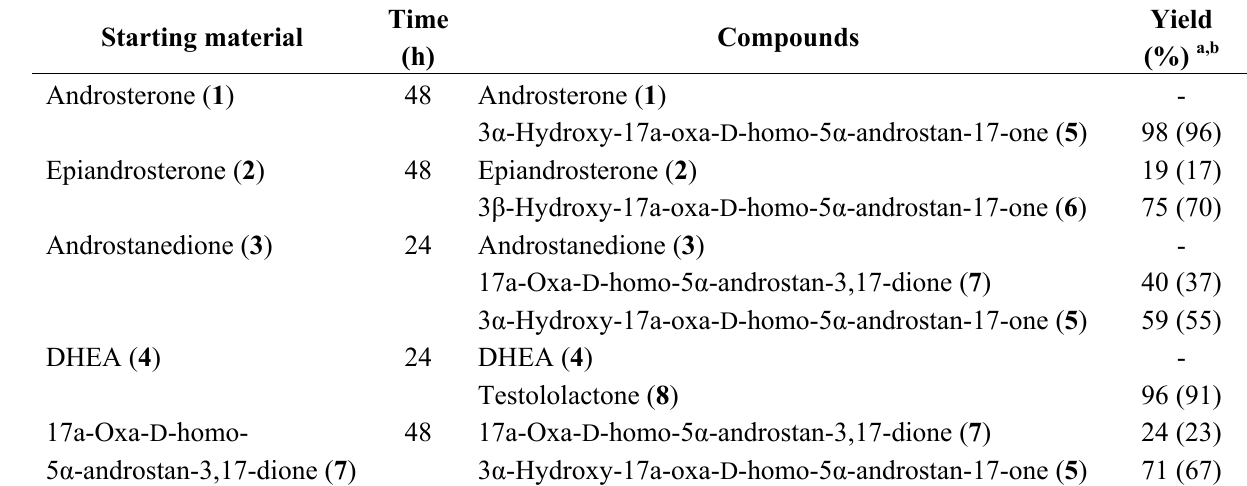
Table 1. The results of transformation of 1 – 4 and 7 by P. lanosocoeruleum . Starting